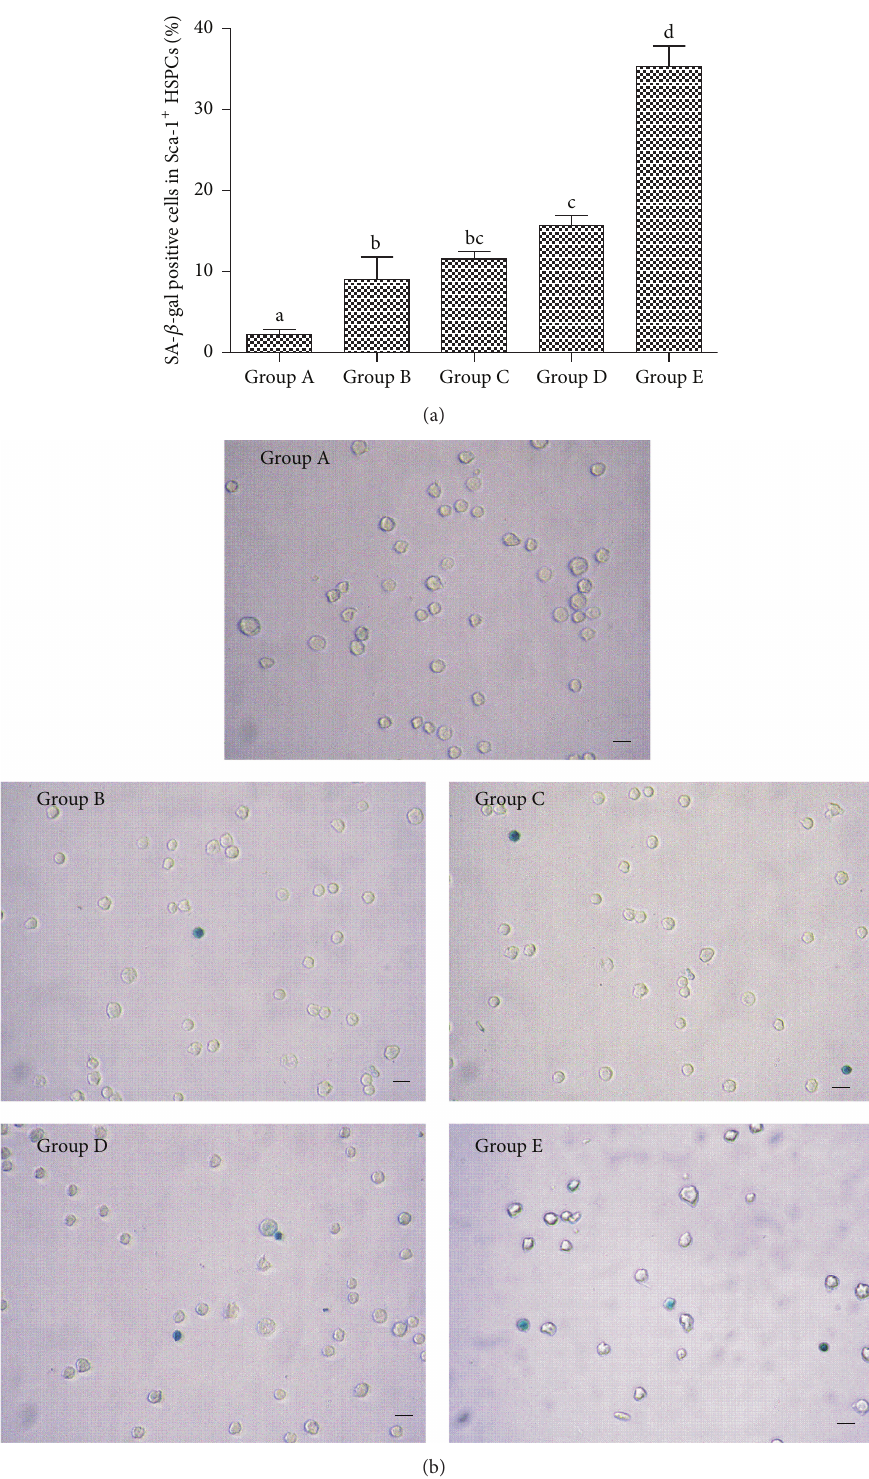
Figure 3: The changes of the SA- 𝛽 -Gal staining in Sca-1 + HSPCs by aging. (a) The percentage of SA- 𝛽 -gal positive cells in Sca-1 + HSPCs (%, 𝑥 ± 𝑠 , 𝑛 = 10 ). Group A: 3-4-week-old mice, 13–16g in body weight. Group B: 8-9-week-old mice, 20–25 g in body weight. Group C: 6-month-old mice, 35–40 g in body weight. Group D: 12-month-old mice, 39–43 g in body weight. Group E: 18-month-old mice, 37–45 g in body weight. (a–d) represent a significant difference of these columns ( 𝑃 < 0.05 ). (b) Representative micrographs depict morphology of SA- 𝛽 -gal positive cells and SA- 𝛽 -gal negative cells in Sca-1 + HSPCs ( × 400). SA- 𝛽 -gal positive cells are dyed in blue. Scale bars indicate 10 𝜇